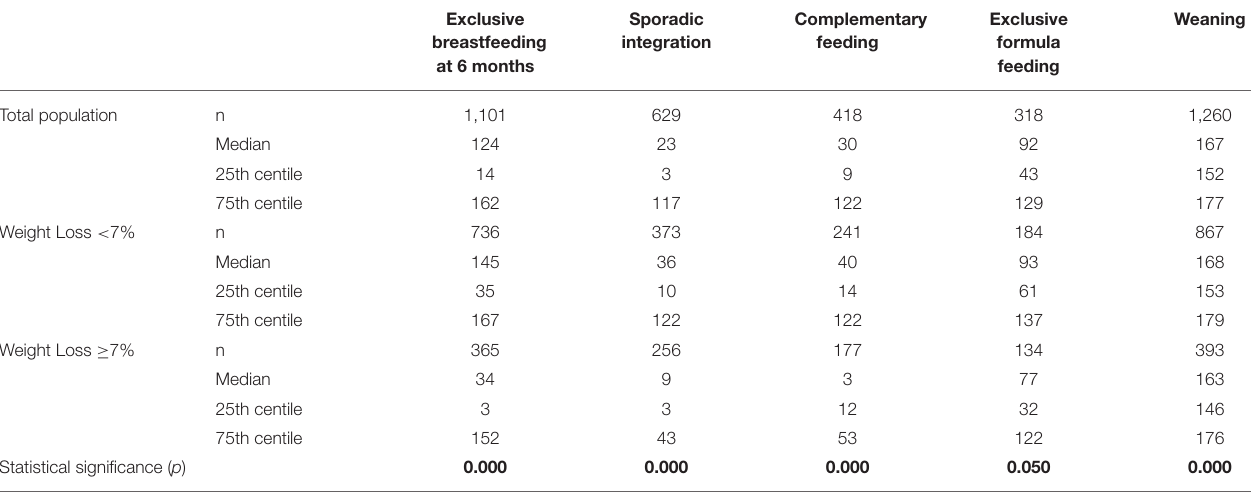
TABLE 3 | Test of the median with independent samples median test.